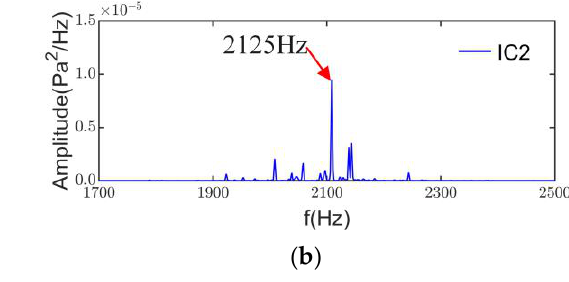
Figure 15. Power spectral density: ( a ) IC1; ( b ) IC2 .